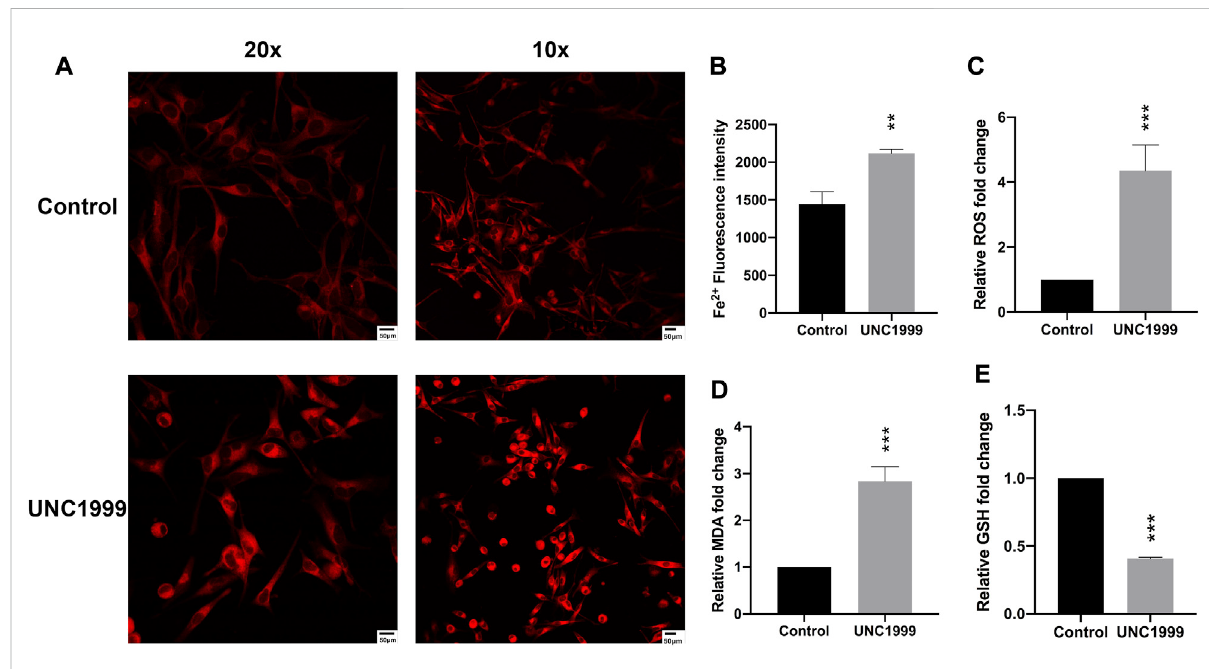
UNC1999 induced ferroptosis. (A,B) The intracellular iron level was increased in OMM1 cells after treatment with UNC1999. (C – E) ROS, MDA, and GSH content were measured in OMM1 cells after treatment with UNC 1999. Data are expressed as mean ± SD from at least three